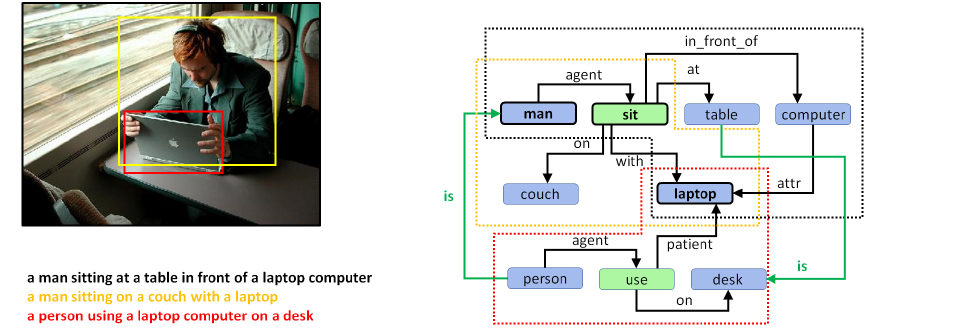
Figure 15. Holistic scene graphs showing three very similar captions, hence demonstrating several merged nodes and several WordNet-based “is”